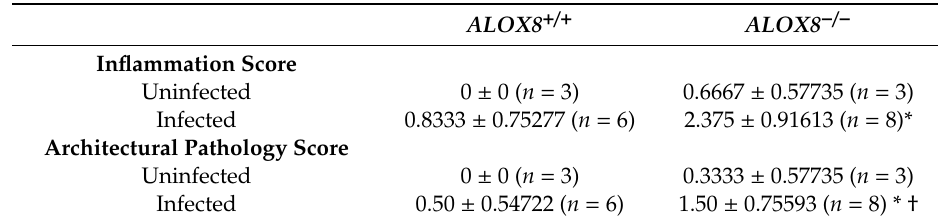
Table 2. Histopathology in lungs of infected and uninfected ALOX8 +/+ and ALOX8 − / − mice (10 days after inoculation).